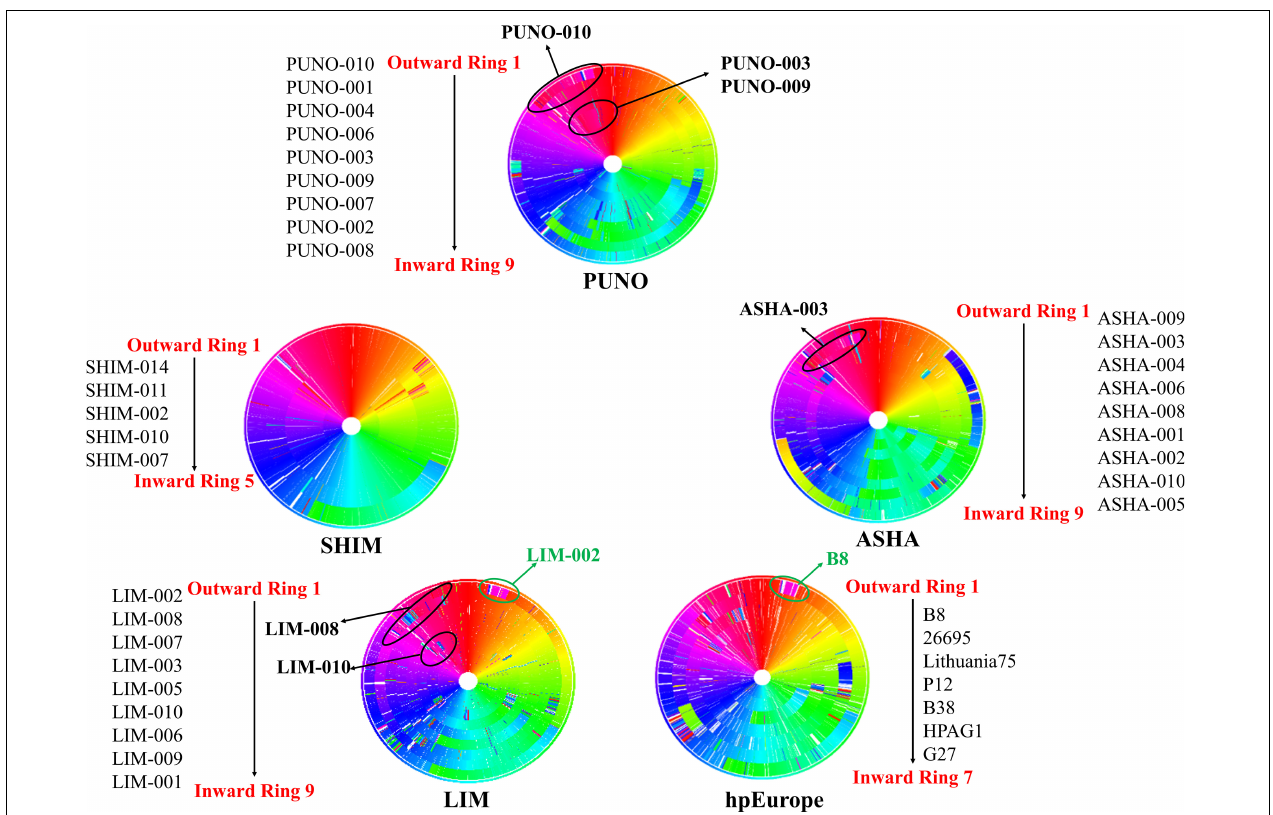
FIGURE 3 | Genomic consensus of the study populations and hpEurope references. These circular views were obtained using the method developed by Tada et al. (2017), which creates a consensus genome that is used as a template for alignment. Each ring represents one complete genome and each block in the ring represents a genomic region. Different colors represent the genes according to their genomic position in the consensus. The shifts in the color represent the rearrangements. The outermost ring is the distant genome from the consensus. The names alongside each circle indicate the genomes going from outward to inward direction. The indicated areas (black circles) in the ASHA (ring 2) and PUNO (rings 1, 5, and 6) genomes show the regions in which these genomes are similar to the LIM (rings 2 and 6). The green circles indicate the similarities between the LIM genomes and the hpEurope references. The genomes ASHA-003, PUNO-003, PUNO-009, and PUNO-010 had an inversion from 10 o’clock to 11 o’clock which was not observed in SHIM